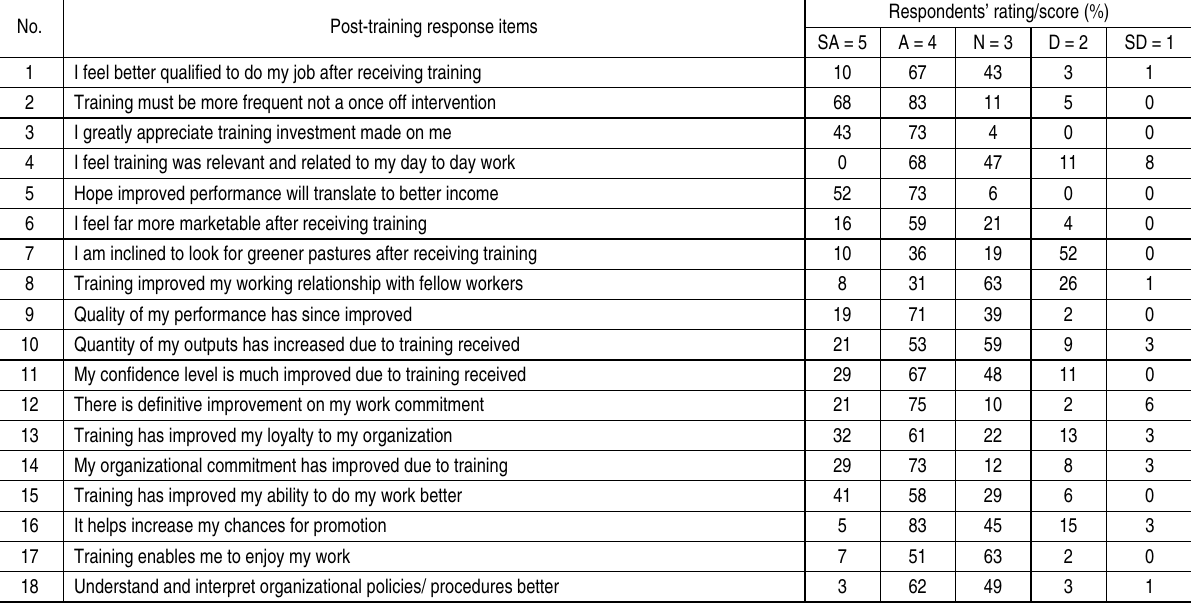
Table 4. Attitudinal and perception variables – post-training on organizational climate No.